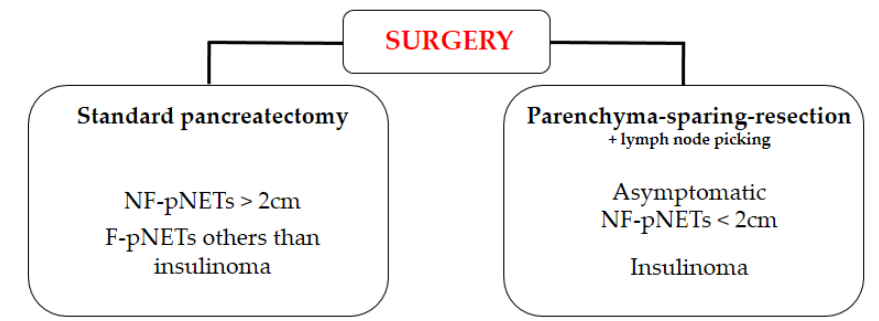
Figure 5. Summary of the indications of standard surgery or pancreatic sparing surgery for pNETs.